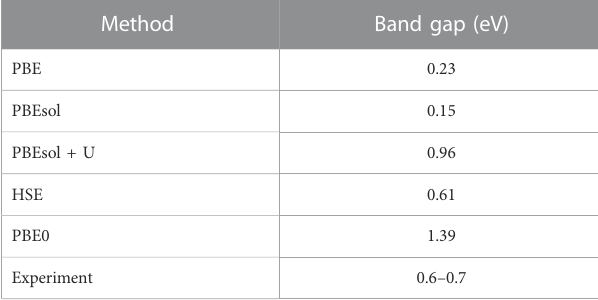
TABLE 1 Calculated electronic band gaps of the VO 2 (M) structure predicted by the PBE, PBEsol, and PBEsol + U, HSE, and PBE0 functionals compared to the experimental